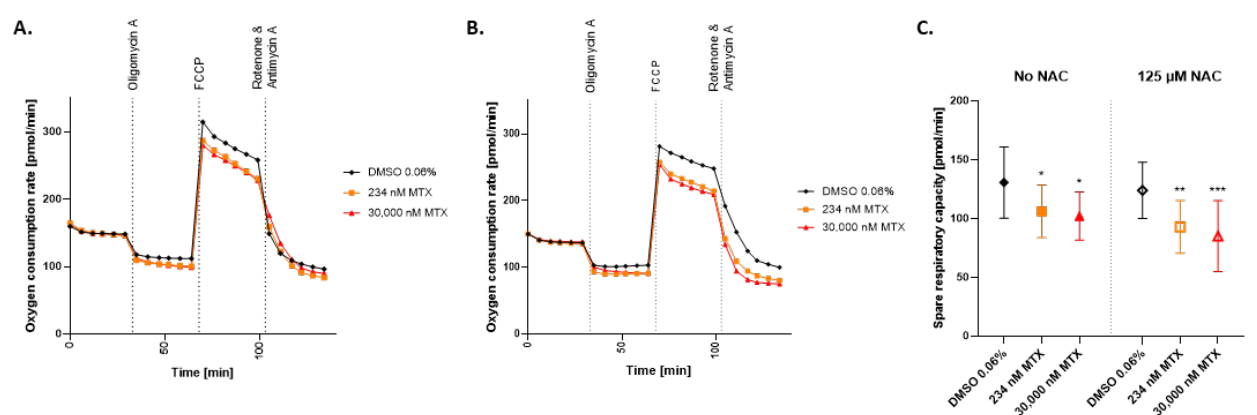
Figure 5. Effect of NAC on oxygen consumption rate in MTX treated HepaRG. The oxygen consumption rate (OCR) of HepaRG exposed to MTX for 72 h ( A ) or HepaRG preincubated with 125 µM NAC and then exposed to MTX for 72 h ( B ), was measured using the Seahorse XF96 analyzer. The HepaRG were sequentially exposed to three treatments: Oligomycin (1 µM), FCCP (2.5 µM), and a mix of Rotenone (0.5 µM) + Antimycin A (0.5 µM). OCR was measured 6 times per treatment step and expressed as pmol/min. Spare respiratory capacity was calculated as the delta maximal respiration to basal respiration ( C ). Graphs represent means ( A , B ), and means ± SD ( C ); statistical analysis based on two-way ANOVA; *, p ≤ 0.05; **, p ≤ 0.01; ***, p ≤ 0.001. ; N = 3.